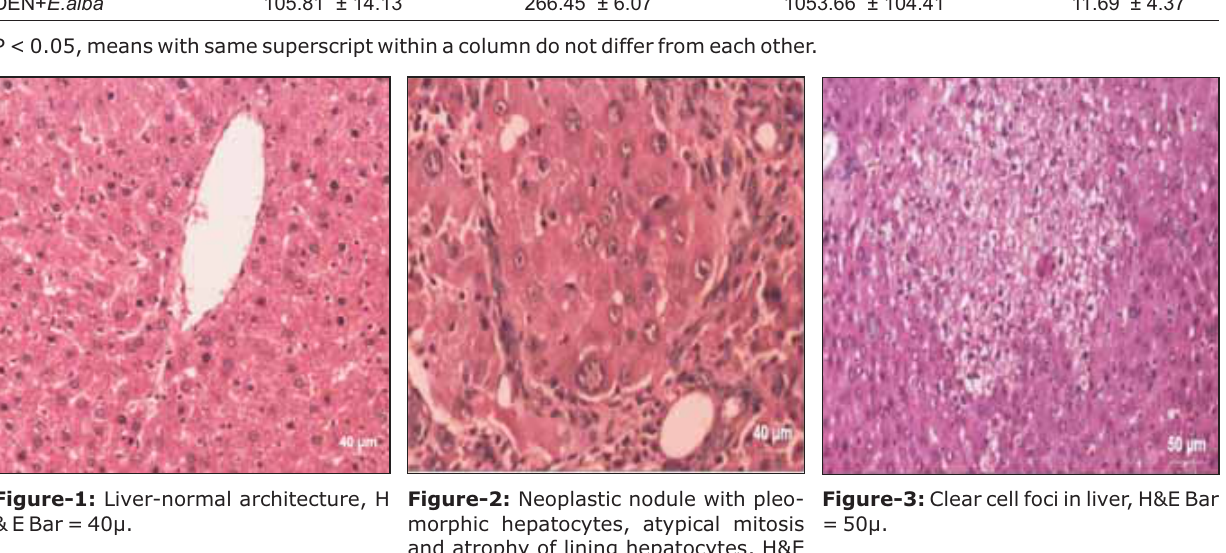
Figure-1: Liver-normal architecture, H & E Bar = 40µ.